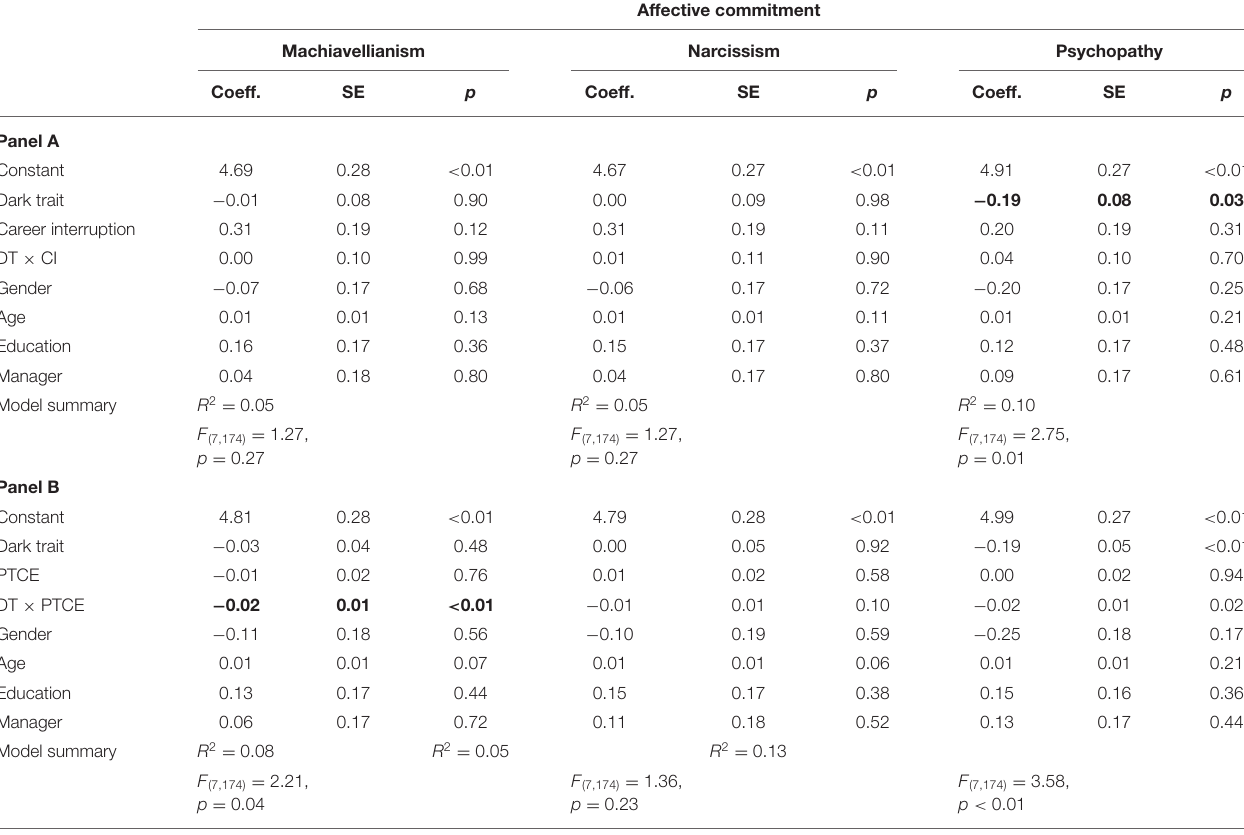
TABLE 2 | Multiple regression coefficients and model estimates predicting affective commitment. Affective commitment Machiavellianism